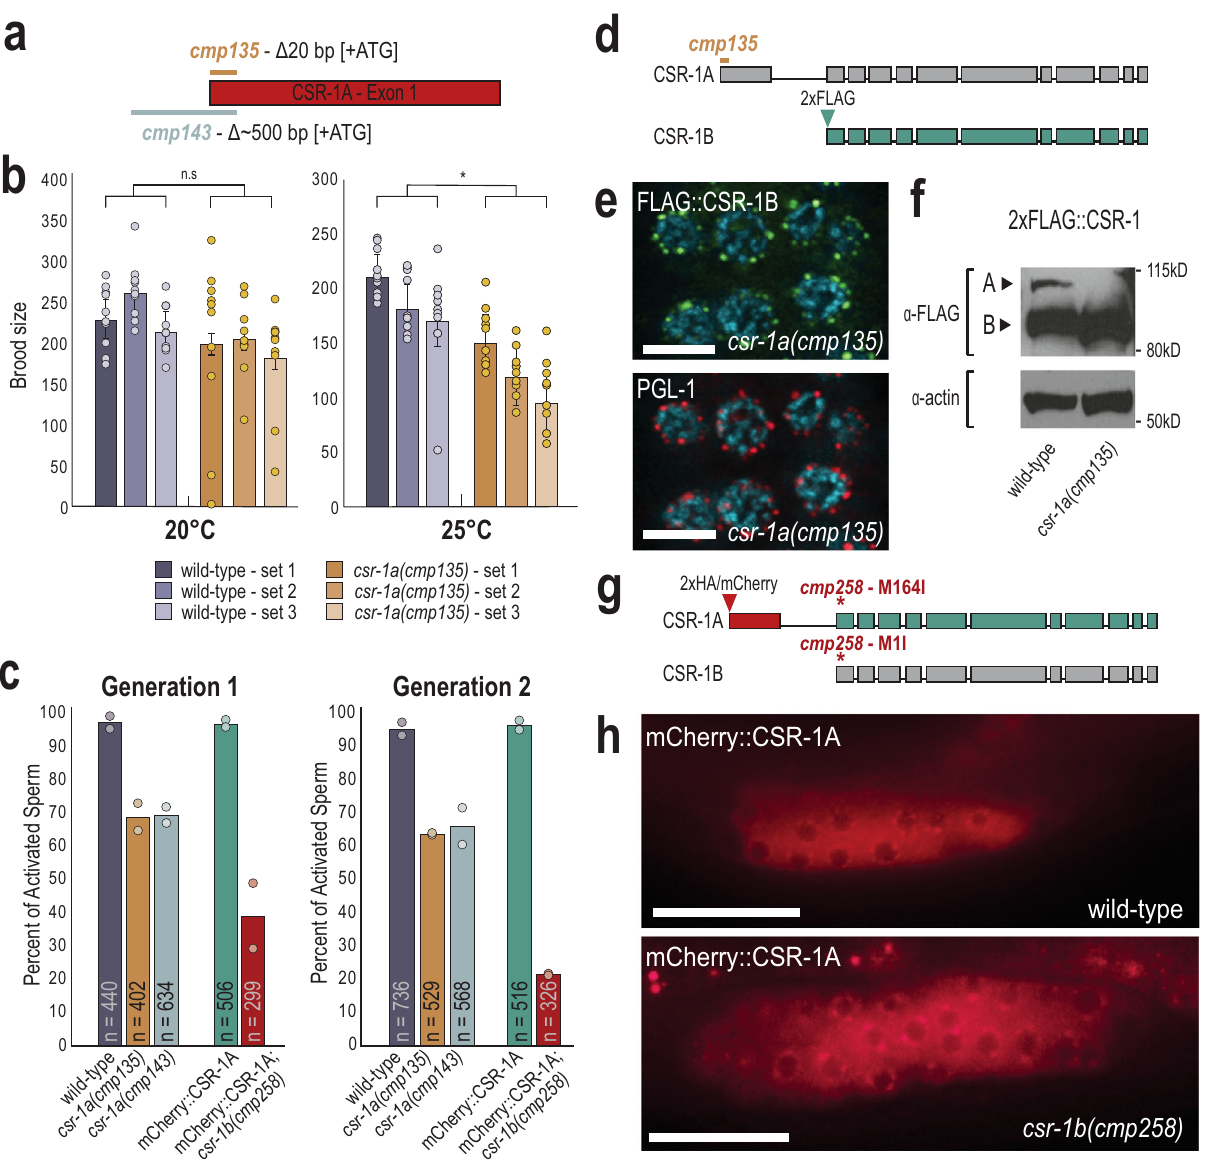
Fig. 3 CSR-1 isoforms function independently of one another. a Schematic representation of two deletion alleles of csr-1a . cmp135 removes 20 bp of coding sequence, including the start codon. cmp143 removes ~500 bp of promoter sequence and 20 bp of coding sequence. b Brood-size assay performed on wild- type and csr-1a mutant animals at 20 and 25 °C. Three replicates were performed for each genotype, with ten animals per replicate. For each biological replicate, brood sizes for all ten animals are shown, with bar graphs representing mean brood size and error bars indicating standard deviation. Two-tail t - tests were performed to determine statistical signi fi cance. n.s. denotes not signi fi cant and indicates a p value >0.05 and * indicates a p value ≤ 0.05. See Supplementary Data 7 for more details regarding statistical analysis. c An in vitro sperm activation assay was performed on spermatids from wild-type, csr- 1a ( cmp135 ), csr-1a ( cmp143 ), mCherry::CSR-1A, and mCherry::CSR-1A csr-1b ( cmp258 ) mutants. Animals were raised at 25 °C for either one or two generations and at least 80 spermatids were counted for each replicate at each generation. Two biological replicates are shown, with bar graphs representing the mean. d Schematic representation of 2xFLAG::CSR-1B in a csr-1a ( cmp135 ) mutant. The 2xFLAG tag was introduced immediately after the CSR-1B start codon in a csr-1a ( cmp135 ) mutant animal. e Immuno fl uorescence staining for 2xFLAG::CSR-1B and P granules (PGL-1) in a csr-1a ( cmp135 ) mutant at L4 stage. The experiment has been reproduced with at least fi ve individual germlines imaged. Scale bar, 5 μ M. f Western blot for CSR-1 expression levels, in wild-type and csr-1a ( cmp135 ) mutant animals at L4 stage. Actin is shown as a loading control. This blot has been reproduced. g Schematic representation of disrupting csr-1b expression in a 2xHA/mCherry::CSR-1A strain. The csr-1b start codon was mutated from methionine to isoleucine (M1I) using CRISPR, which also introduces a M164I point mutation in the CSR-1A protein. h Live imaging of mCherry::CSR-1A in a wild-type and csr-1b ( cmp258 ) mutant L4 hermaphrodite. At least fi ve individual germlines were imaged for each strain. Scale bar, 25 μ M. Source data are provided as a Source Data fi